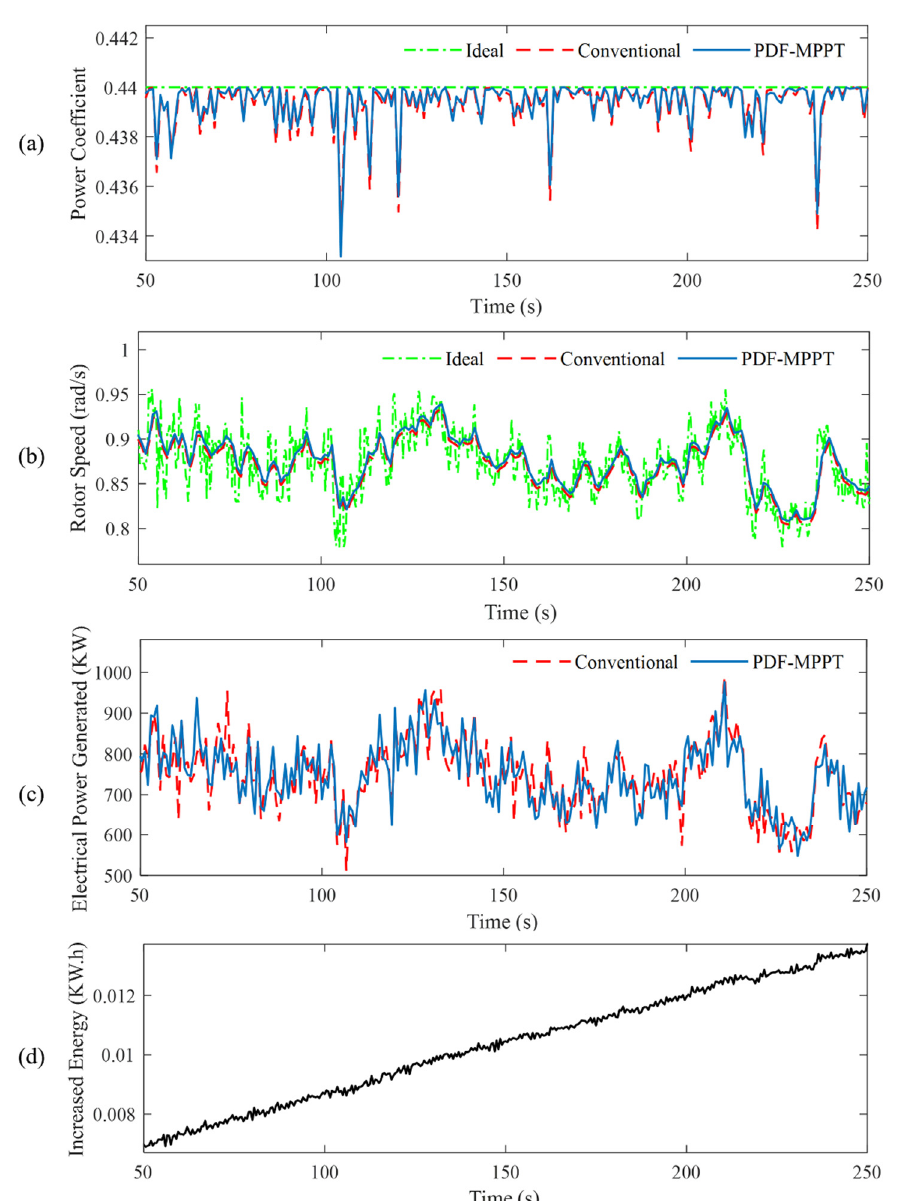
Figure 7. Simulation results using PDF-MPPT method and conventional MPPT method for the turbulent wind speed with constant average value: ( a ) power coefficient; ( b ) rotor speed; ( c ) electrical power generated; ( d ) cumulative generation increment of using PDF-MPPT method comparted with conventional MPPT method. The green line with the legend of “ideal”, the blue line with the legend of “conventional” and the red line with the legend of “PDF-MPPT” in ( a – c ) means the corresponding performance index in ideal operation state, using the conventional MPPT method and using the novel MPPT method, respectively.